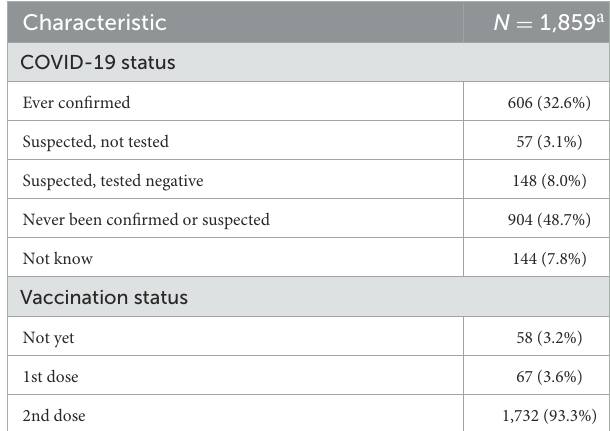
TABLE 1 General characteristic of study participants.